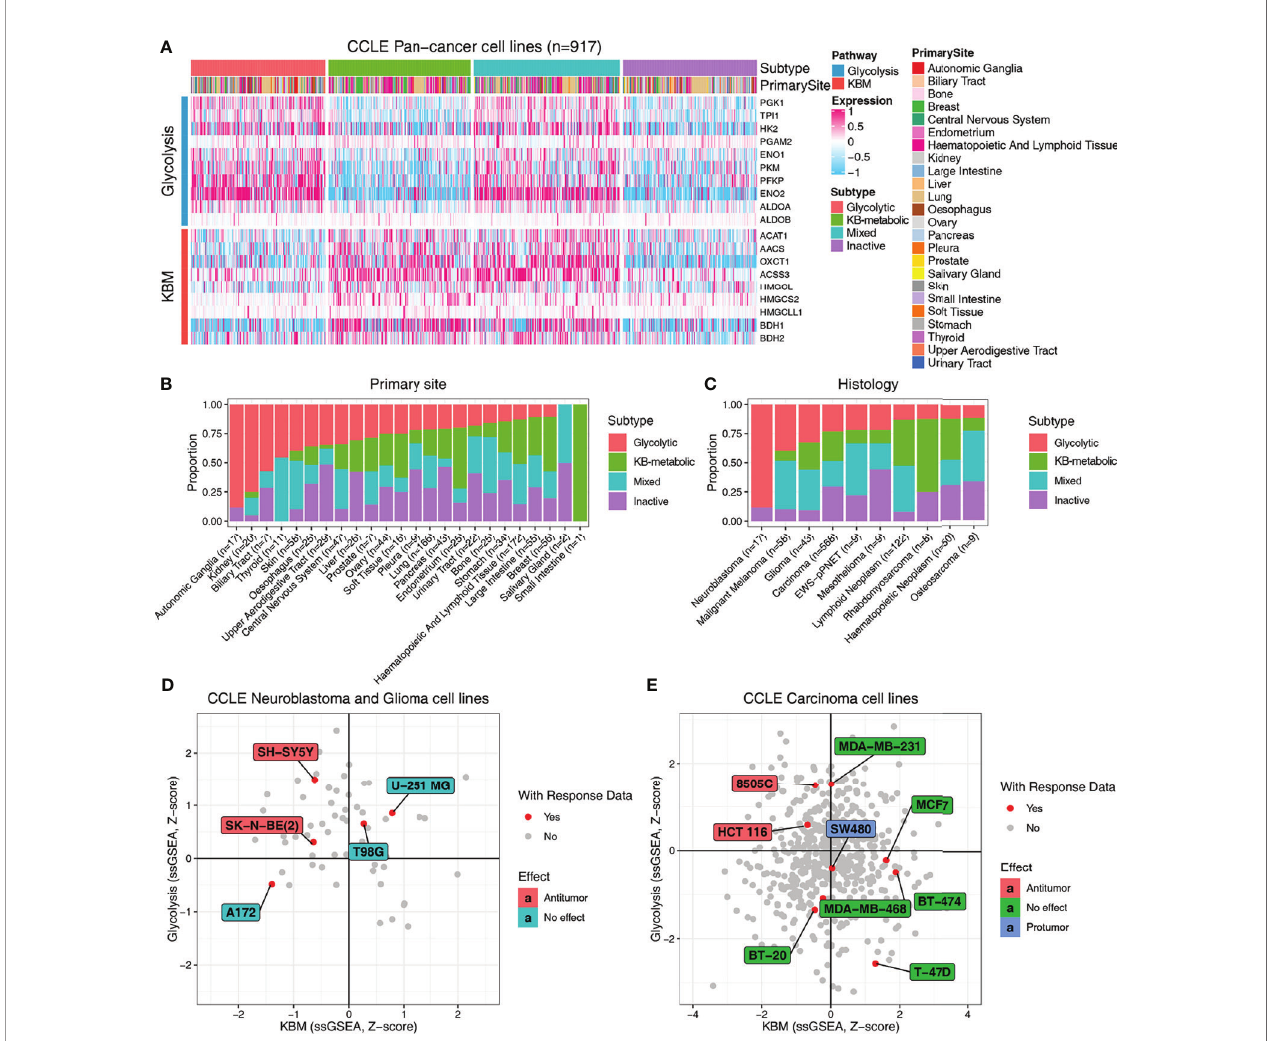
FIGURE 5 | Metabolic subtypes based on glycolysis and KBM genes are informative about the response to KDT. (A) Heatmap presenting the expression pattern of glycolysis and KBM genes in each subtype across CCLE cancer cell lines. The proportion of four metabolic subtypes based on primary site (B) and histology (C) in the CCLE cell lines. The metabolic subtypes of neuroblastoma and glioma (D) and carcinoma cell lines (E) and their relationship with the reported response data of ketogenic